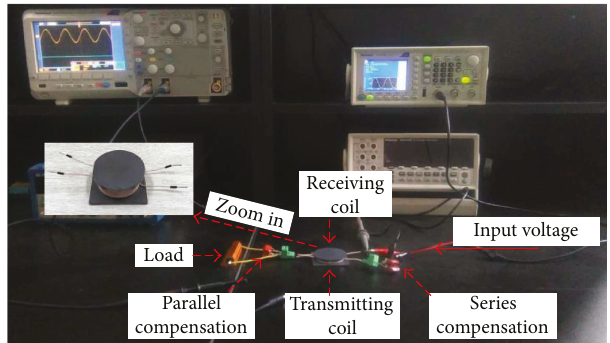
Figure 3: Photograph of the series-parallel compensated WPT experimental setup.